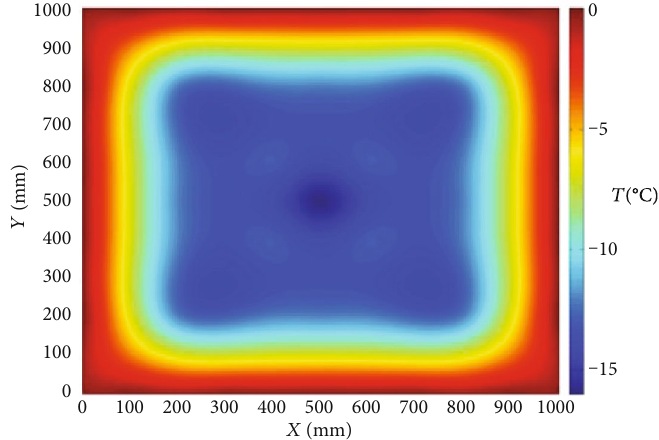
Figure 5: Cloud picture of temperature at a cross-section.